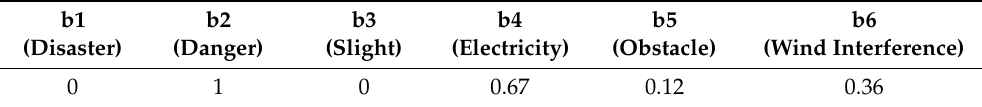
Table 6. Standardized real-time attribute data.